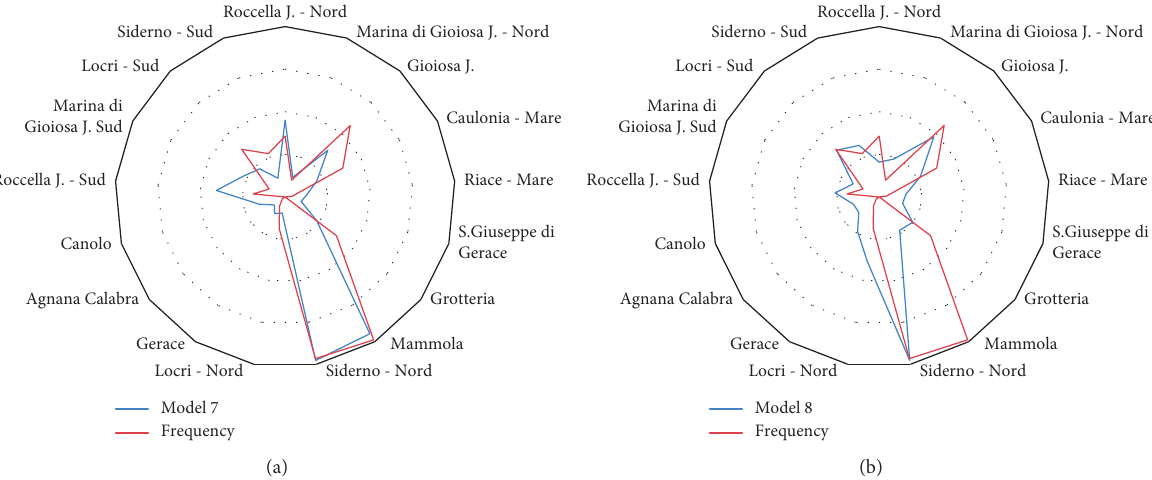
Figure 8: Comparison between observed and estimated values of attracted freight vehicles. Radar diagrams for model 6 (a) and model 7